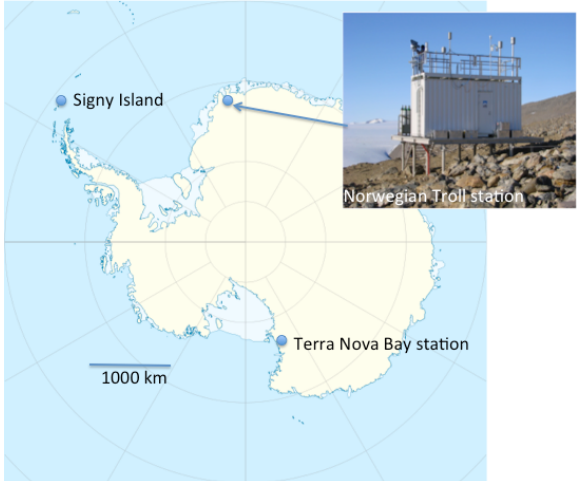
Figure 1: The position of the Antarctic Troll Atmopsheric observatory (Norwegian Troll 4 Fig. 1. The position of the Antarctic Troll Atmospheric observatory research Station, dronning Maud Land, Antarctica). For comparison the British 5 (Norwegian Troll research station, Dronning Maud Land, Antarc- research stations Signy Island and the Italian Terra Nova Bay stations are shown. 6 tica). For comparison the British research station Signy Island and the Italian Terra Nova Bay station are shown. Map: courtesy of